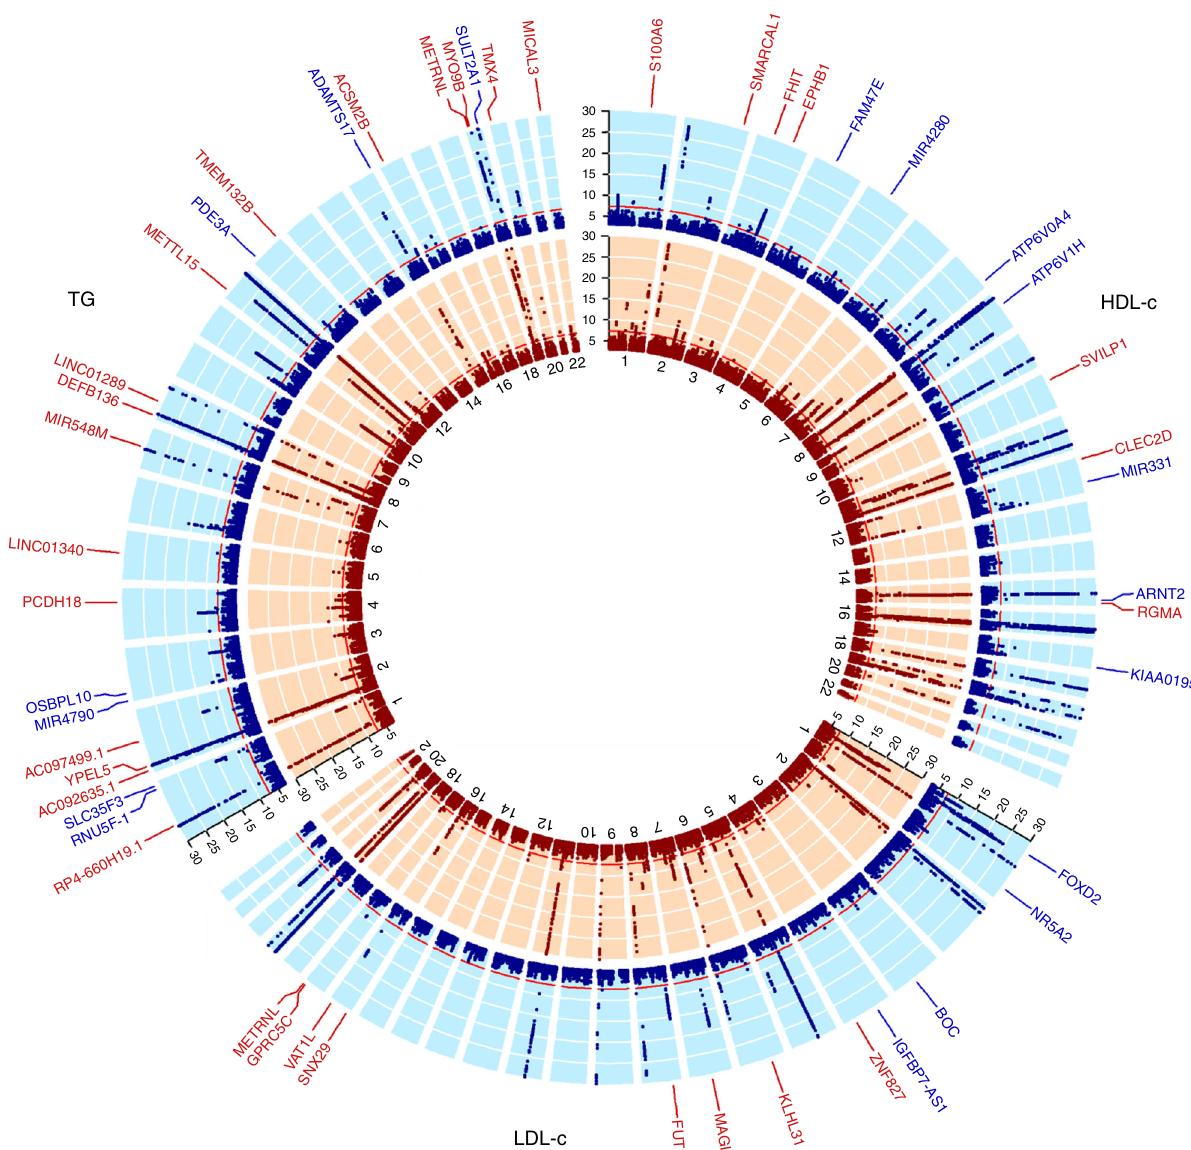
Fig. 2 log( P -value of 2df interaction analyses) plots of the multi-ancestry analyses. Plot visualises the – log( P -values in the 2df interaction test) for HDL-c, LDL-c and TG per chromosome. In red (inner circle) are the – log( P -value) plots for the analyses taking into account potential interaction with short total sleep time. In blue (outer circle) are the – log( P -value plots for the analyses taking into account potential interaction with long total sleep time. Loci de fi ned as novel and replicated are labelled. Replicated variants had to have 2df interaction test P -values of Stage 1 < 5 × 10 − 7 , Stage 2 < 0.05 with a similar direction of effect as in the discovery meta-analysis and Stage 1 + 2 < 5 × 10 − 8 . Labelled gene names in red were identi fi ed in the STST analysis; labelled gene names in blue were identi fi ed in the LTST analysis. All – log( P -value in the 2df interaction test) > 30 were truncated to 30 for visualisation purposes only. The unlabelled regions with P < 5 × 10 − 8 in the 2df interaction test were in known loci. Figure prepared using the R package circlize